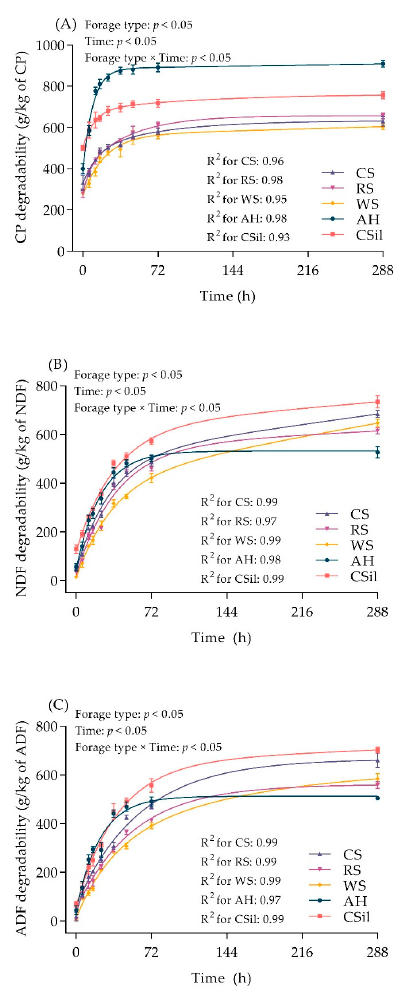
Figure 1. The real-time degradability of various forages during 288 h in situ incubation. ( A ) CP, ( B ) NDF, and ( C ) ADF. Data are expressed as means ± standard deviation. p -values of Forage Type, Time, and Forage Type × Time mean the effect of forage types, the effect of incubation times, and the interaction effect of forage types and incubation times. Data were fitted to a one-phase association exponential model with three parameters: y = a + b × [1 − exp ( − c × t)], where y is the ruminal degradation of CP, NDF, and ADF at time t, a is the soluble or rapidly degradable fraction (g/kg); b is the potentially degradable fraction (g/kg); c is the constant rate of degradation of b (%/h); t is the time of incubation (h). Regression, p < 0.05; R 2 for CS, RS, WS, AH, and CSil = 0.93 to 0.99, as shown in the graph. CS, corn straw; RS, rice straw; WS, wheat straw; AH, alfalfa hay; Csil, corn silage; DM, dry matter; CP, crude protein; NDF, neutral detergent fiber; ADF, acid detergent fiber. Each forage was incubated in 6 replicates (two for each time point per cow) in the